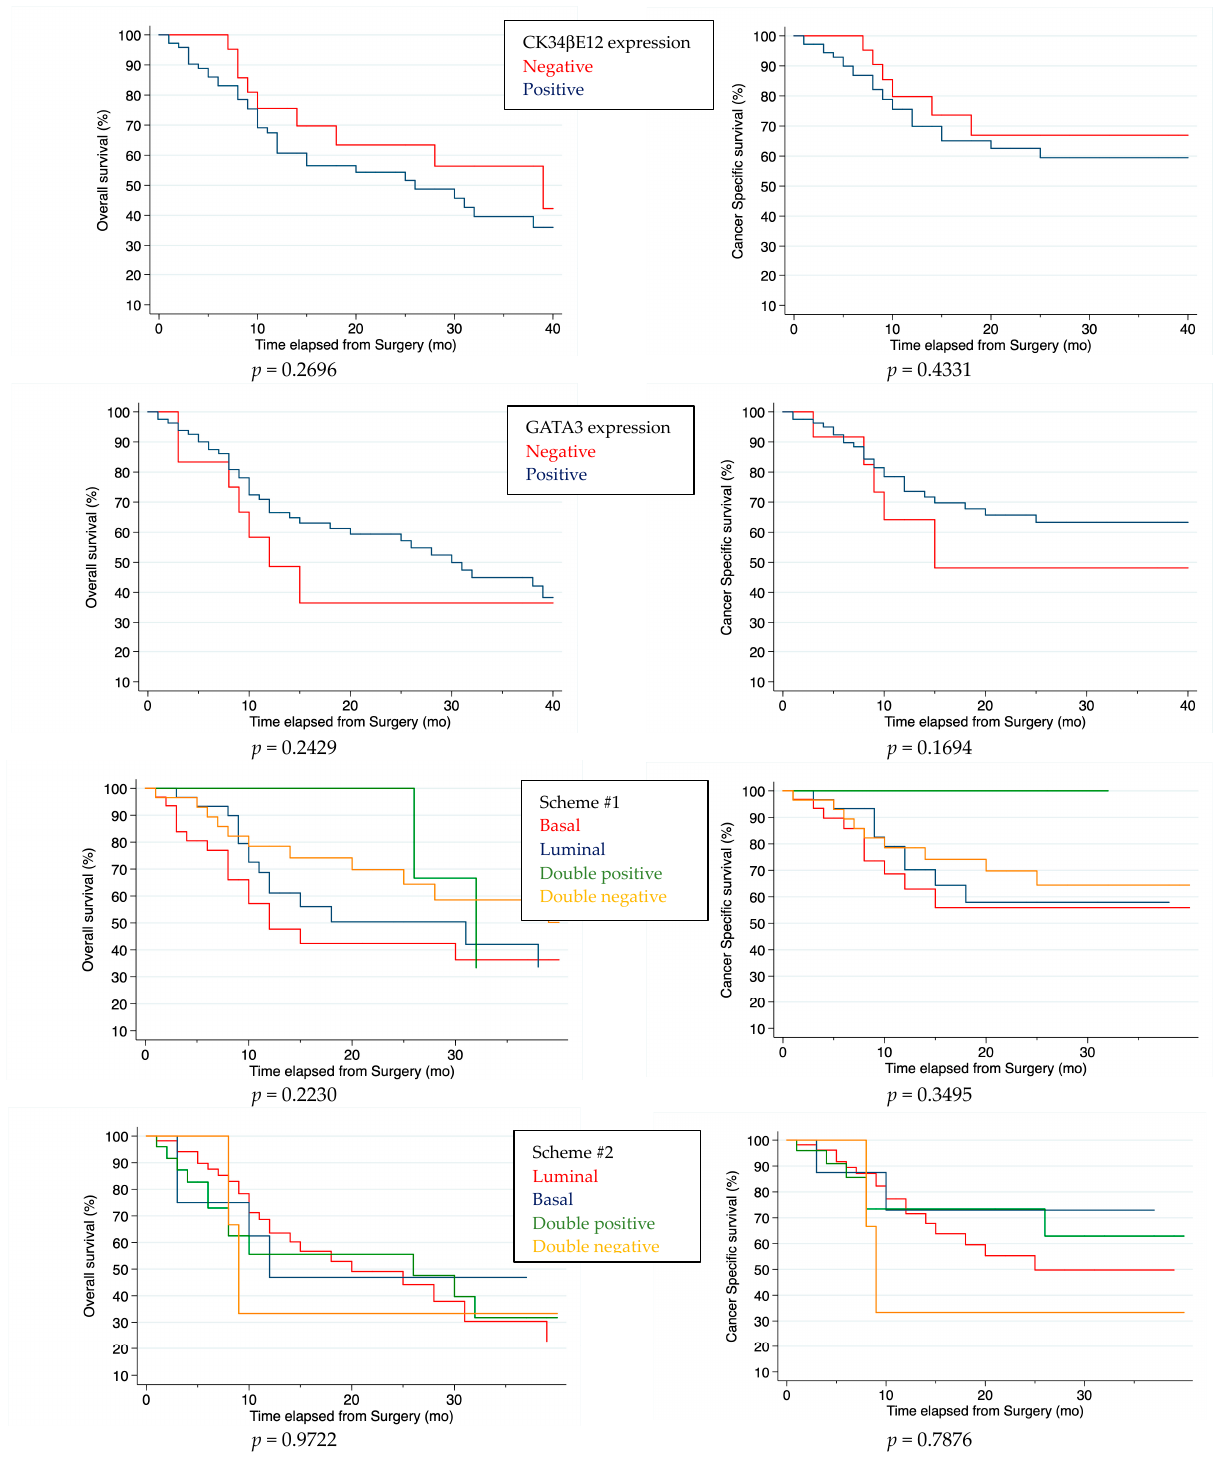
Figure 2. Kaplan–Meier analysis of single and combined marker expression.